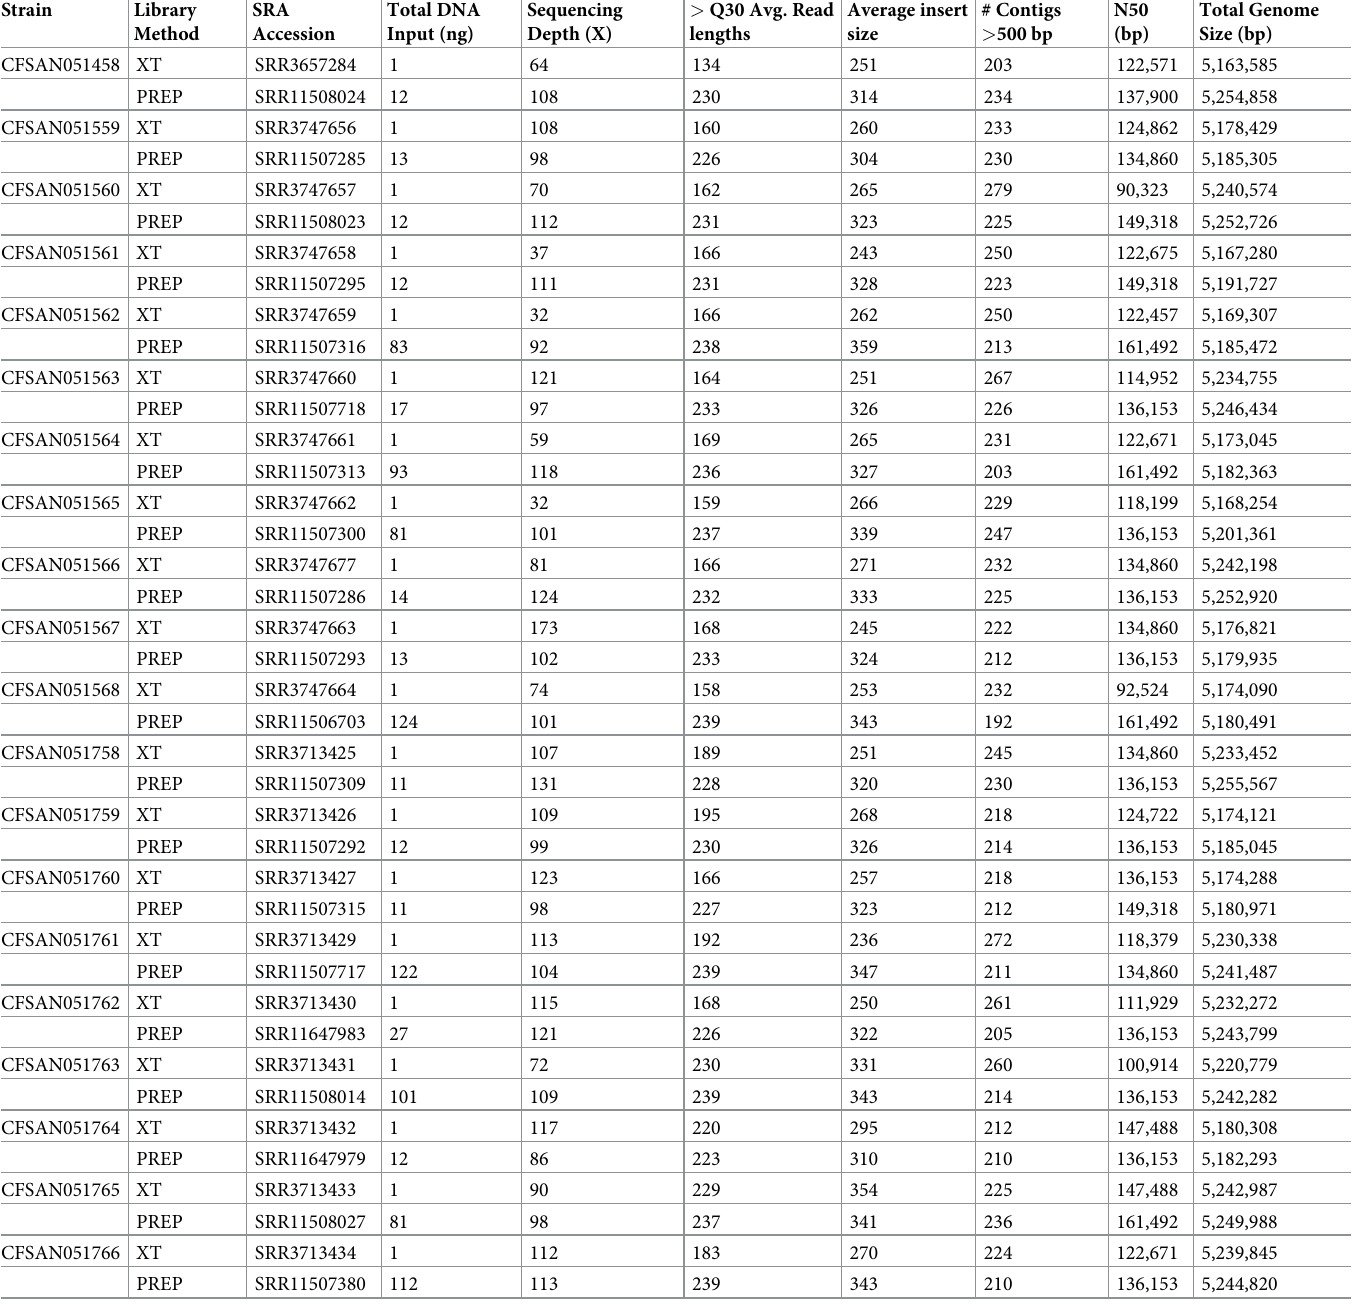
Table 2. Assembly statistics by DNA library kit for each strain.